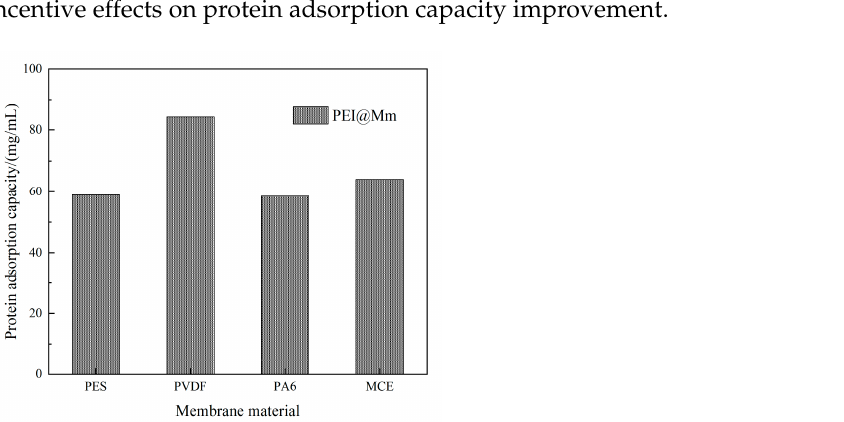
Figure 4. Effect of membrane material (different functional groups) on the protein adsorption performance of the MAs.